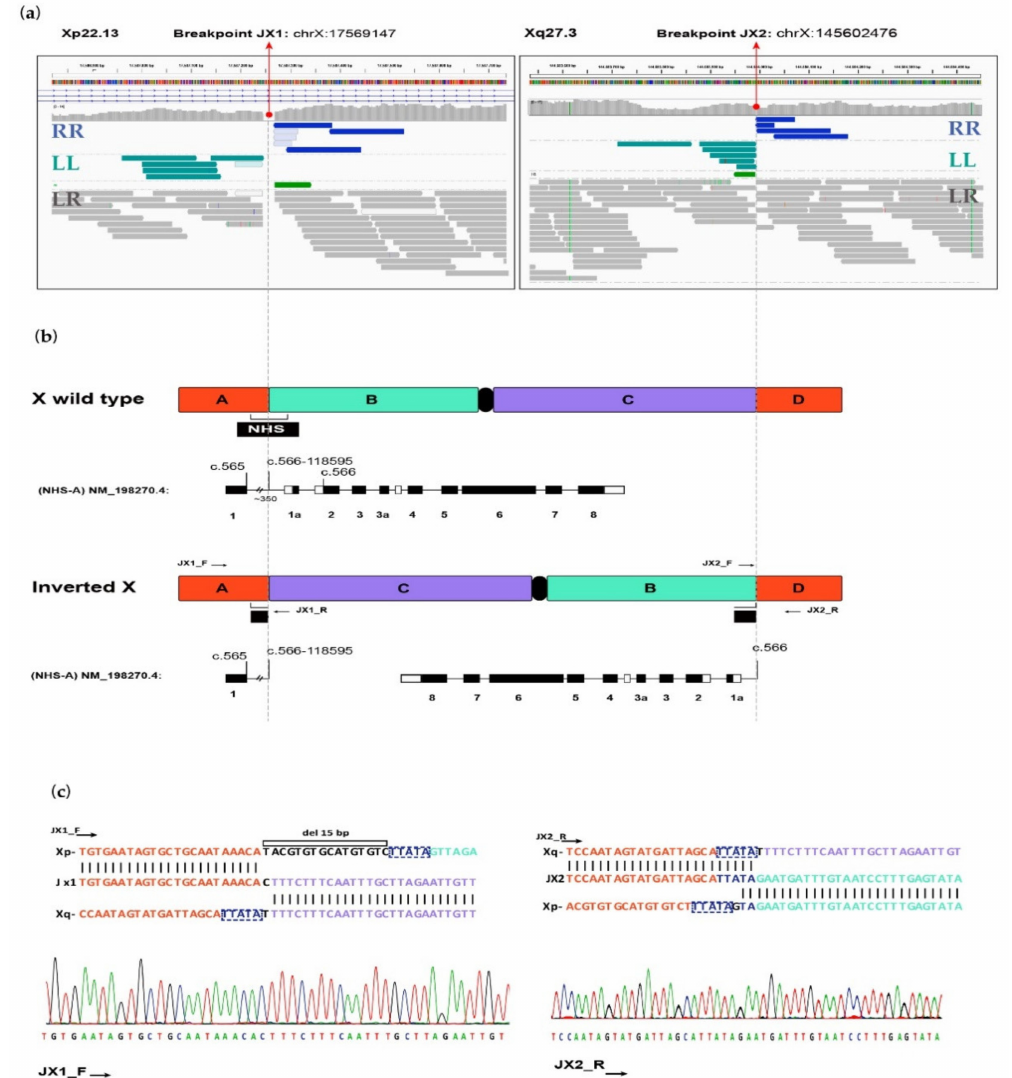
Figure 2. Fine mapping of the balanced pericentric large inversion Inv (X)(p22.13q27.3) by whole genome sequencing. ( a ) Integrative Genomics Viewer (IGV) screenshot of the genomic regions containing the proximal JX1 breakpoint at Xp22.13, disrupting the intron 1 of NHS , and the distal JX2 breakpoint at an intergenic region of Xq27.3 of the 128-Mb inversion identified in the index case. Gene, read coverage, and alignment tracks are shown from top to bottom. Reads are grouped and coloured by pair orientation. Normal left-right (LR) paired reads are coloured in grey. Discordant reads with